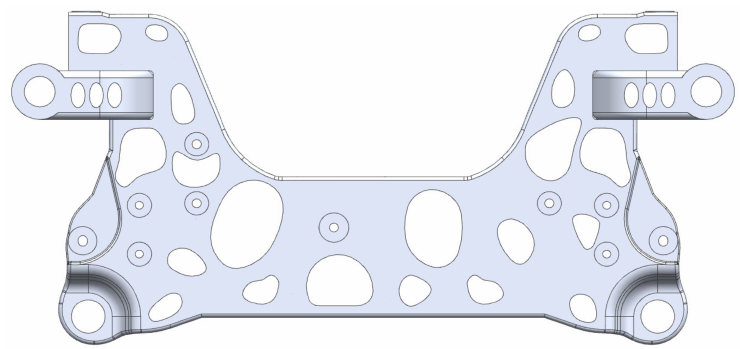
Figure 3. Aluminium alloy front subframe detailed design of digital